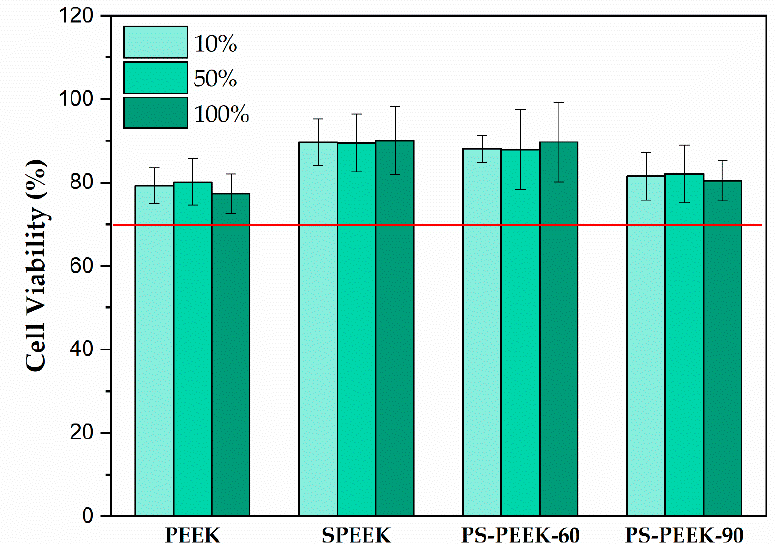
Figure 3. Evaluation of cell viability percentage of PEEK, SPEEK, PS-PEEK-60 and PS-PEEK-90 extracts in contact with cells and minimum percentage (red line) that corresponds to the value established by the ISO 10993-5 2009 standard.